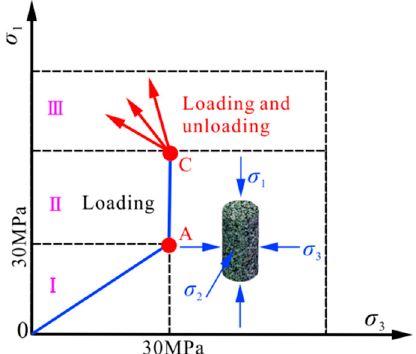
Figure 3. Schematic diagram of the loading and unloading pathways. Note: I, II and III represent the first, second and third stages of loading and unloading test, respectively. A and C are initial confining pressure point and initial point of unloading confining pressure, respectively.